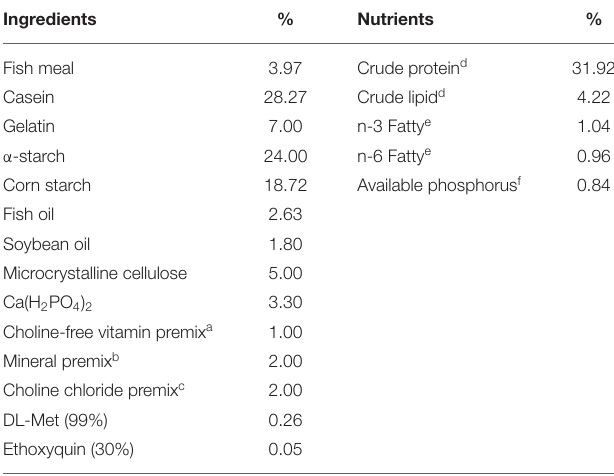
TABLE 1 | Composition and nutrients of basal diet.